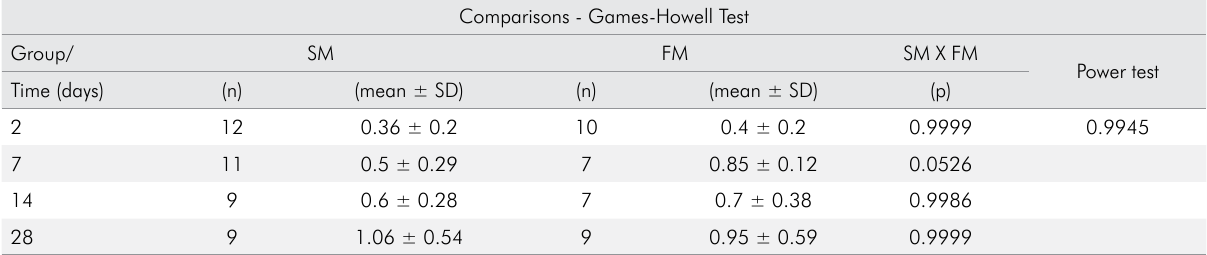
Table 1. Means and standard deviations of tooth movement amount (mm) in saline with tooth movement group (SM) and fluoxetine with tooth movement group